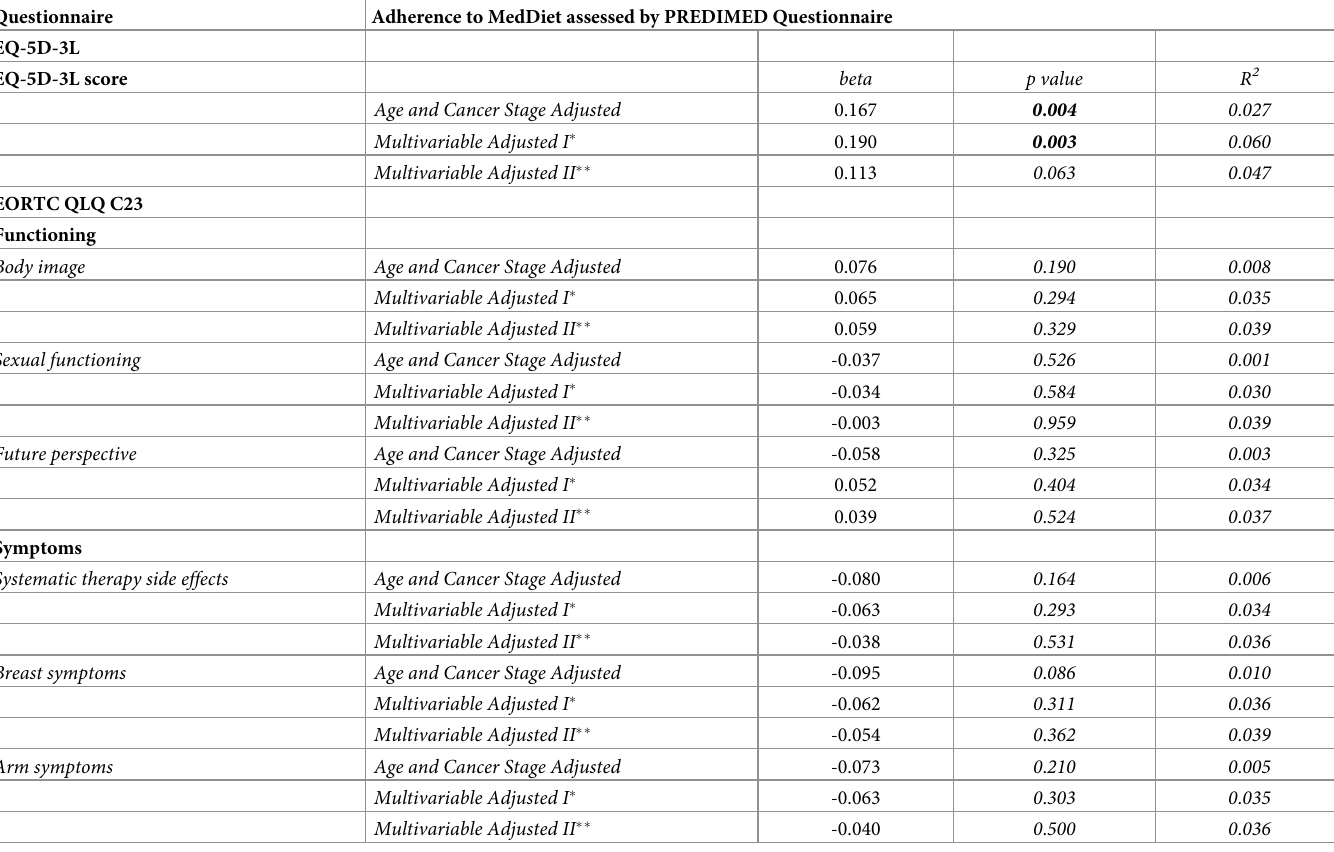
Table 5. Association between adherence to the Mediterranean Diet (MedDiet) and HRQoL questionnaires EORTC QLQ-BR23 and EQ-5D-3L.